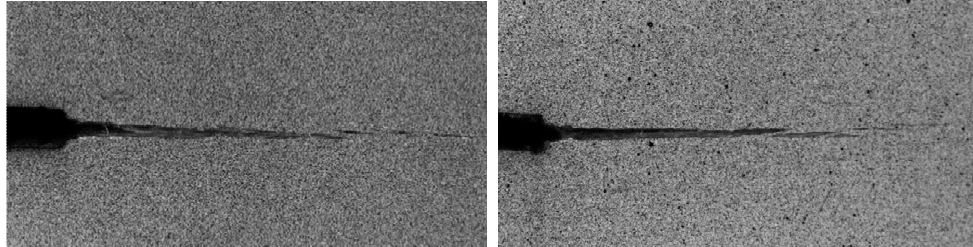
Figure 4. Macroscopic images of crack propagation: “DCB 176-3 RL” (left); “DCB 192-2 TL” (right).